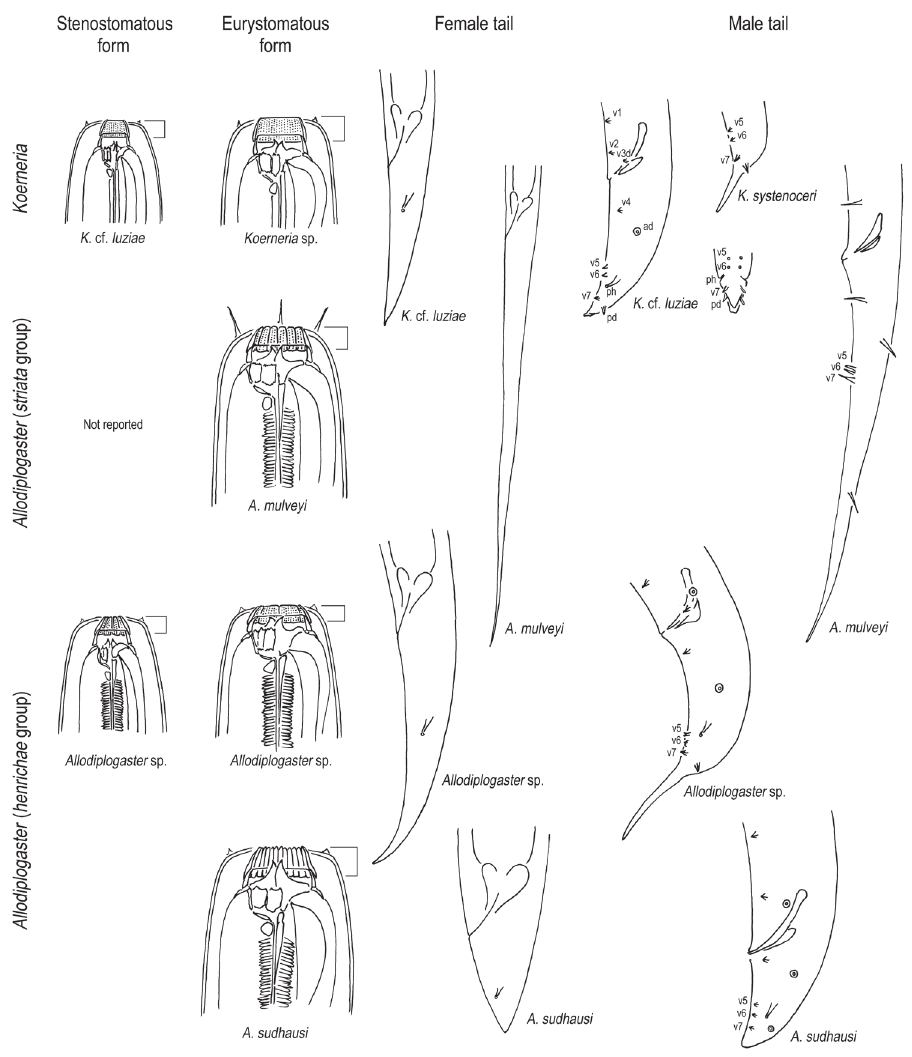
Figure 2. Schematic drawings of the generic characters of Koerneria and Allodiplogaster . From left to right: stenostomatous form, eurystomatous form, female tail, and male tail characters. From top to bot- tom: Koerneria , aquatic Allodiplogaster (“ striata ” species group) and two types of terrestrial Allodiplogaster (“ henrichae ” species group). For the stenostomatous form of A. sudhausi (not shown), see Fürst von Lieven (2008). Squared bracket indicates cheilostom, which as undivided separates Koerneria from Al- lodiplogaster . Further diagnosing Koerneria is the arrangement of male genital papillae v5-v7. Unique to the striata group of Allodiplogaster relative to the henrichae group and to Koerneria are a long tail in both sexes, setiform genital papillae, and in many cases setiform labial papillae. Genital papillae and phasmids are labeled following the terminology in Sudhaus and Fürst von Lieven (2003). The phasmids are not clearly described in species of the striata